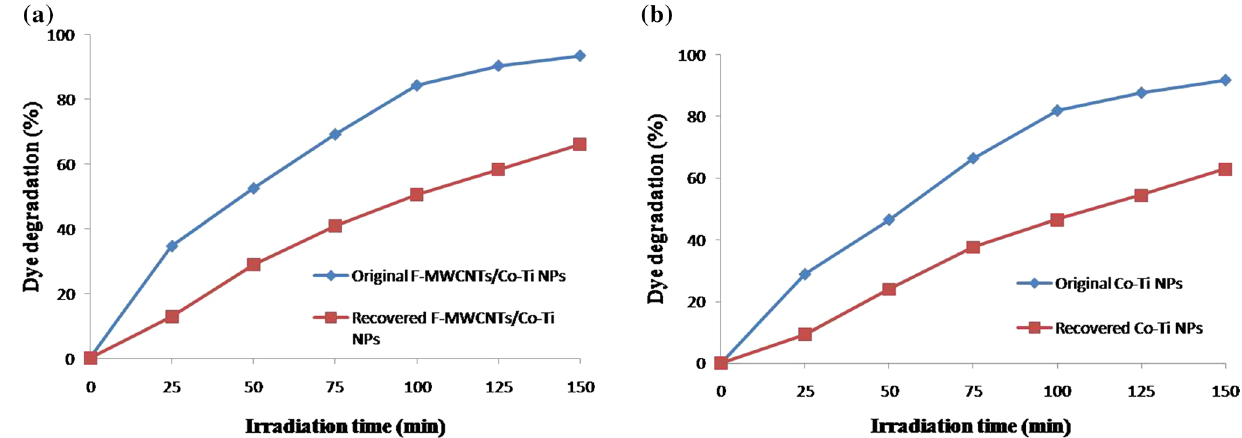
Fig. 8 Comparison of the %degradation of RB dye by original and recovered a A-MWCNTs/Co–Ti oxide NPs and b Co–Ti oxide NPs